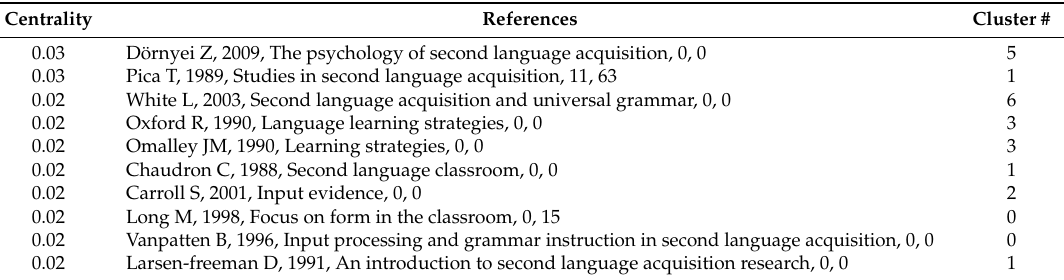
Table 14. The pivotal works in second language